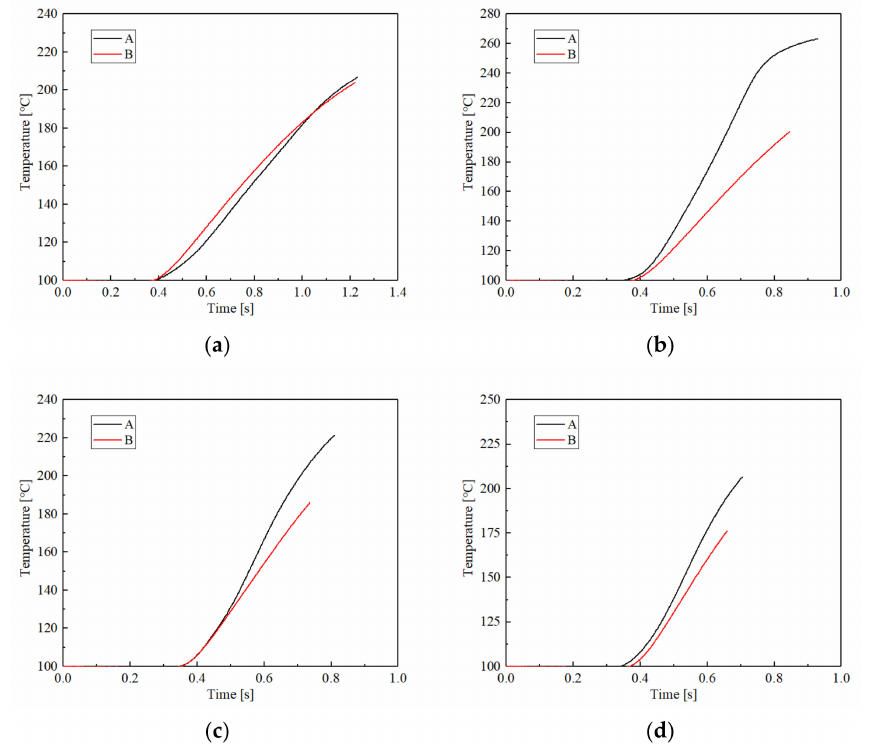
Figure 7. The temperature changes of samples A and B at different applied pressures. ( a ) 1 MPa;